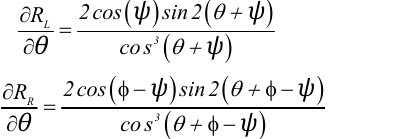
Figure 6. GSD ratio variation for ψ , ψ , and ψ positions 1 2 3 It can be observed that when camera position is located in left half of the circular arc, GSD at left edge is superior to GSD at right edge at equal angular distance from the optical axis of the camera and vice versa. GSD of normal image is always superior compared to that of the convergent images. Moreover, for a given corner geometry, GSDs at left and right edges of a convergent images vary according to camera position and also degrades at different rates towards image edges. For example, for a convergent image acquired by a camera position at 39.428° on the circular path, GSD at the left edge is approximately 4-5 times higher than the GSD at the right edge. However, the former is Figure 8. Building corner site (  = 90°) also 5 times lower than the GSD at edge of a normal image. In other words, GSD at right edge is 25 times lower than that of the For the selected corner site of a building, lower parts of two normal image. It can also be observed that GSD of left edge curve facades are considered for the experiments. As shown in the and GSD of right edge curve are mirror reflection for the camera figure 8, right façade of the corner is a homogenous surface. position that are equidistant from mid-point on the circular path Whereas, the left façade is characterized by the alternate red in opposite directions. strips interspaced by slits of another colour. This arrangement provides heterogeneous surface in the left potion of the façade near the corner. However, the farther portion of the same façade is homogeneous in texture. To understand the impact of rate of GSD variation on keypoint detection across a convergent image, checkerboards each of 37mm grid size, containing total 5x8 grids, and 28 cm width are applied on the surfaces of the